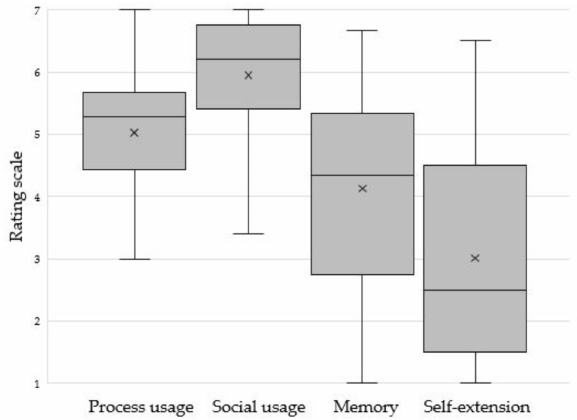
Figure 3. Standardized descriptive statistics of smartphone usage behavior (SUB). Box-plots depict the range of the inner 50% (box), the median (line dividing the box), minimum (bottom whisker), maximum (upper whisker) and the mean (X). Table 2. a–c. Results of the evaluation of H2 comparing smartphone and neutral control object, H4b comparing smartphone neutral and smartphone plus activated self-relevance and H4a comparing smartphone plus activated self-relevance and neutral control object. T -tests comparing different experimental conditions for significant mean differences, one-tailed. SM = smartphone, SM_SR = smartphone plus activated self-relevance, SM_N = smartphone neutral, NEUT = neutral control object (wooden block). * Significant at p < 0.05, one-tailed. ** Significant at p < 0.001, one-tailed. M in cm, SD in